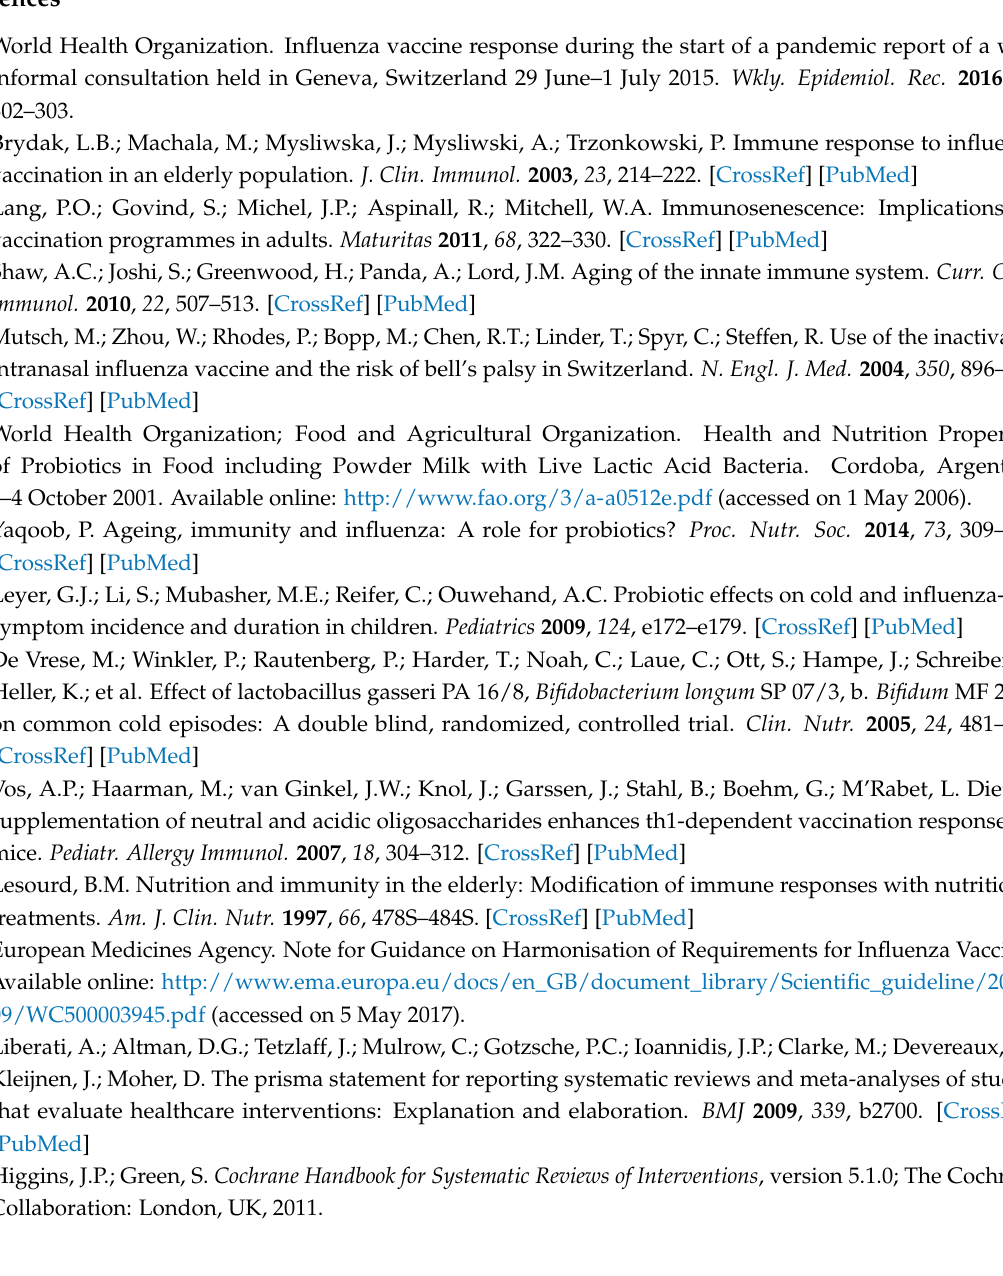
Table S1: PRISMA checklist, Table S2: Detailed searching strategy, Table S3: Quality assessment of included studies based on Cochrane risk of Bias tool, Table S4: Publication bias assessment with Egger’s regression, Figure S1: Funnel plot of seroprotection rate of H1N1 strain, Figure S2: Funnel plot H3N2 seroprotection, Figure S3: Funnel plot B seroprotection, Figure S4: Funnel plot H1N1 seroconversion, Figure S5: Funnel plot H3N2 seroconversion, Figure S6 :Funnel plot B